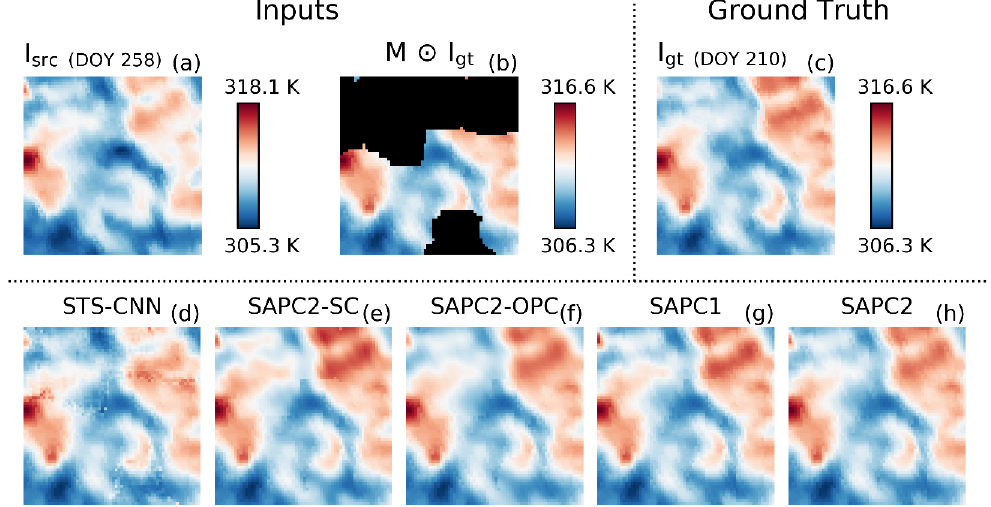
Figure 11. The same as Figure 9 but for Case 3 (acquisition DOYs for source and target inputs are 258 and 210, respectively). The masked fraction of the target image ( b ) is 0.448. The correlation coefficient between source ( a ) and ground truth ( c ) images is 0.955.